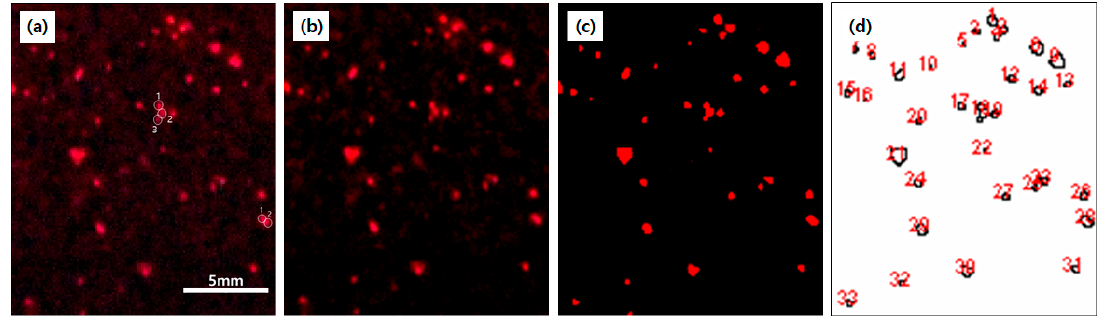
Figure 3. Image processing of CNT aggregates ( a ) Original image; ( b ) Removal of noise; ( c ) Thresholding; ( d ) Analyzed particle image.